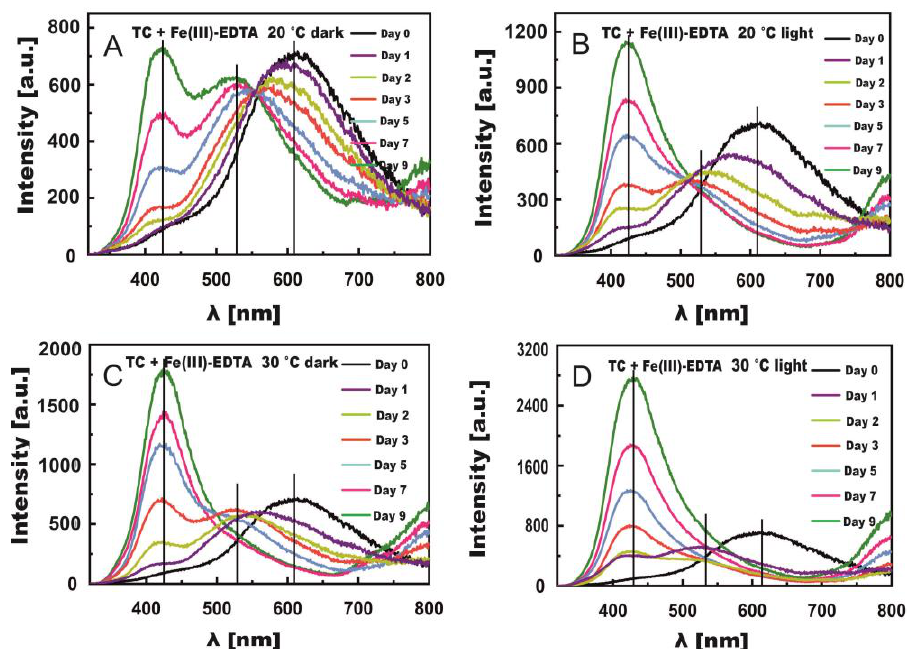
Figure 6. Changes in fluorescence spectra induced by Fe(III)-Cit in TC solutions stored in the dark ( A , C )and in light ( B , D ) at temperatures of 20 °C ( A , B ) and 30 °C ( C , D ). ( A , C ) and in light ( B , D ) at temperatures of 20 ◦ C ( A , B ) and 30 ◦ C ( C , D